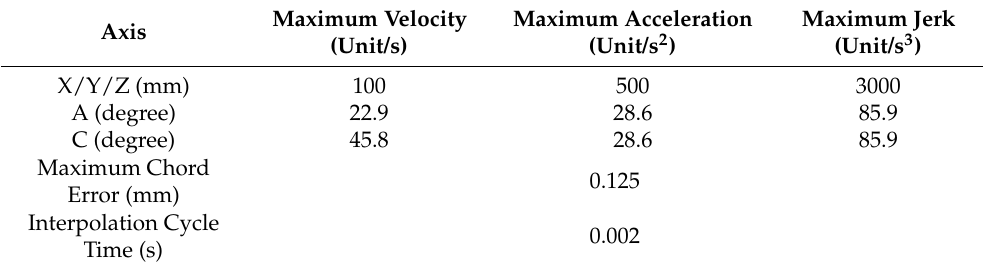
Table 2. The kinematic and dynamic constraints of the five-axis machine tool and the geometric constraint.